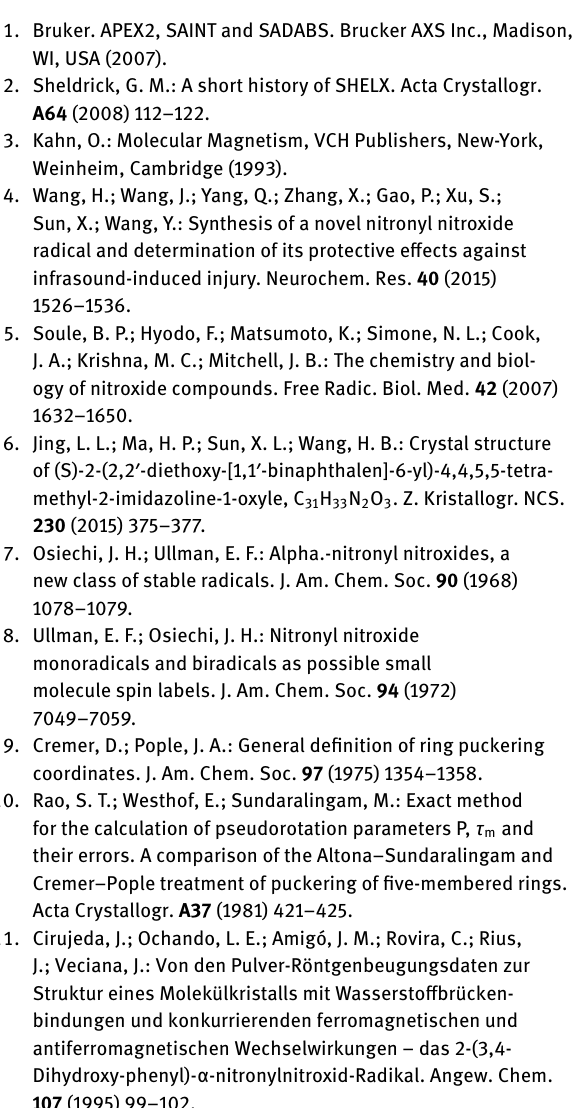
As shown in the figure, the nitronyl nitroxide ring and the phenyl rings are twisted with respect to each other making a dihedral angle of 43.37(11)°. The puckering para- meters of the nitronyl nitroxide ring are Q(2) = 0.216(3) Å and φ = 123.6(8)° [9]. The pseudorotation parameters [10] for the nitronyl nitroxide ring are P = 285.1(6)° and τ(M) = 22.1(2)° for the C1—N1 reference bond with the closest